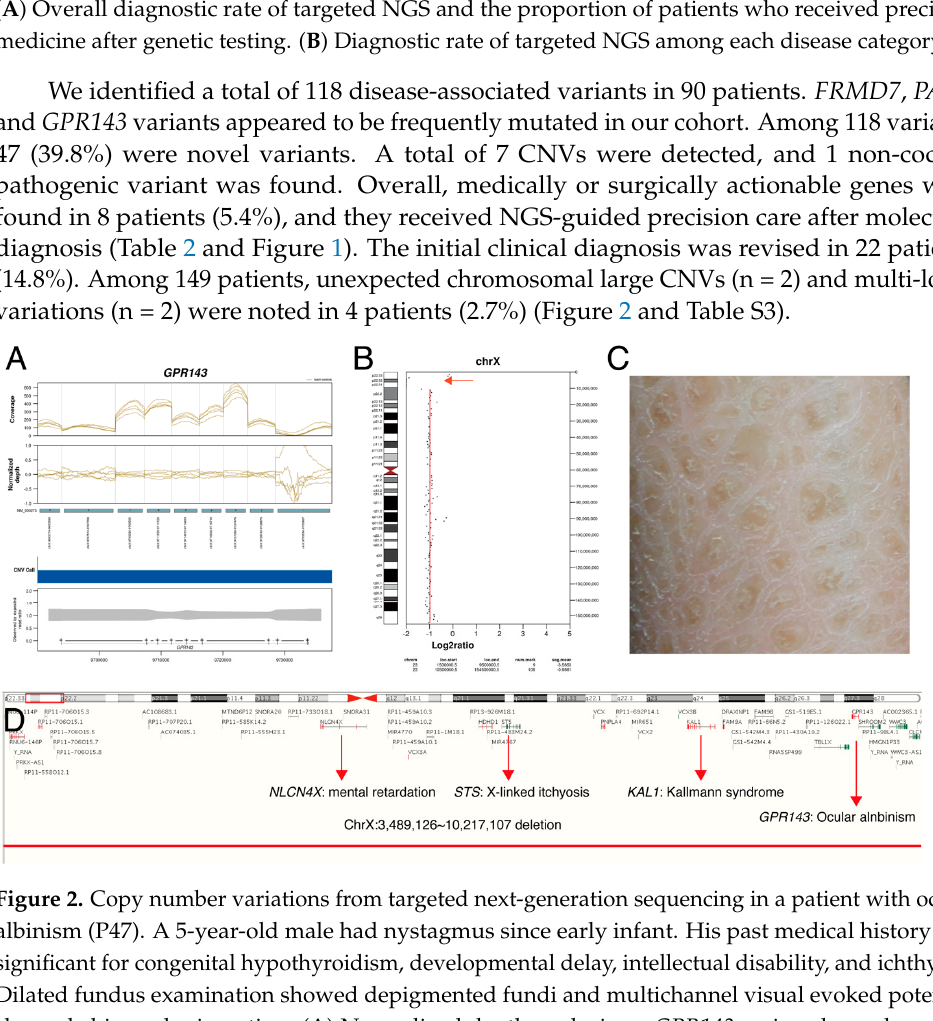
Figure 2. Copy number variations from targeted next-generation sequencing in a patient with ocular albinism (P47). A 5-year-old male had nystagmus since early infant. His past medical history was significant for congenital hypothyroidism, developmental delay, intellectual disability, and ichthyosis. Dilated fundus examination showed depigmented fundi and multichannel visual evoked potential showed chiasmal misrouting: ( A ) Normalized depth analysis on GPR143 region showed a whole gene deletion of GPR143 ; ( B ) chromosomal copy number variations called by off-target analysis using CopywriteR version 2.9.0 showed absence of read depth on Xp22.3 (red arrow); ( C ) dry,